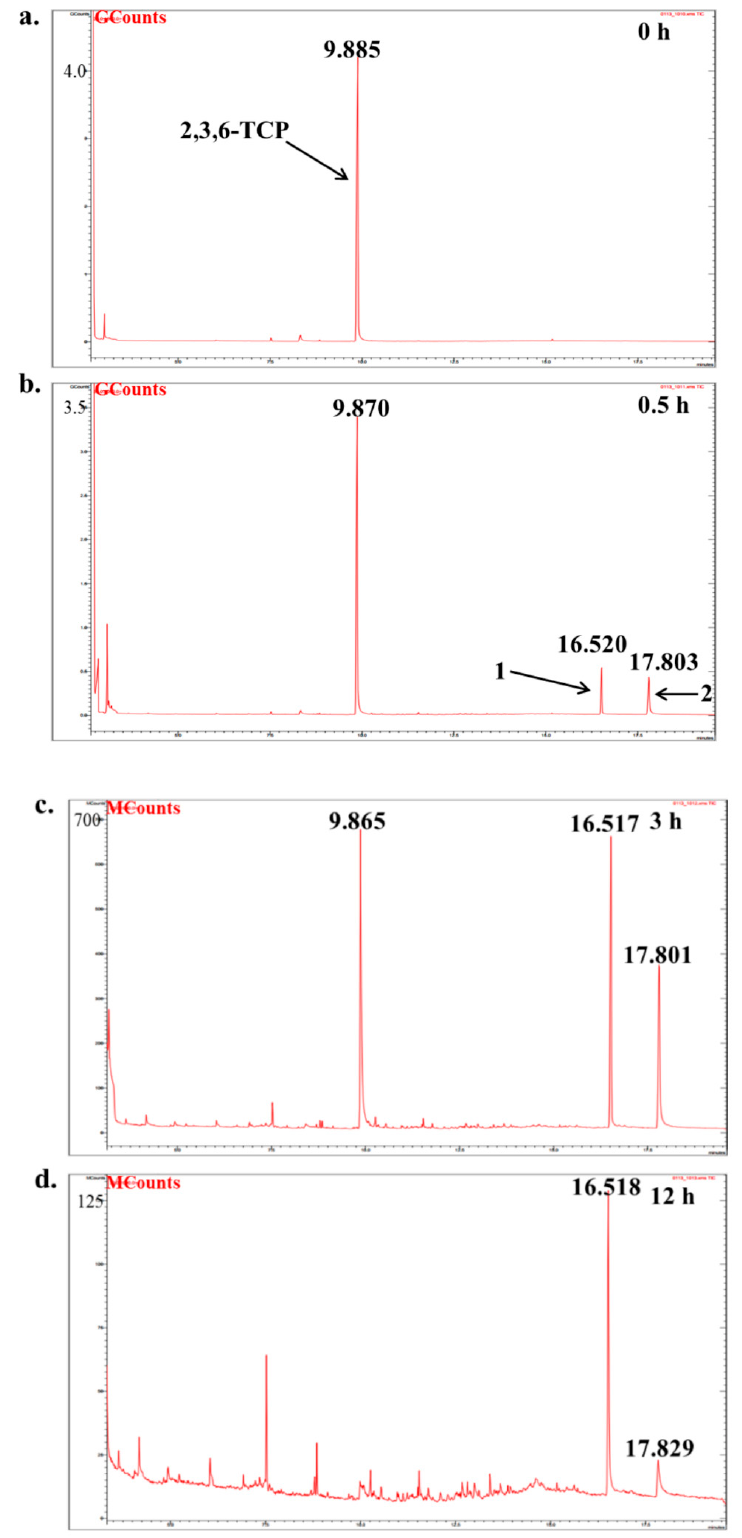
Figure 13. Gas chromatography (GC) peak spectra of degradation products of 2,3,6-TCP degraded by LAC-4 at different time points. ( a ) 0 h, ( b ) 0.5 h, ( c ) 3 h, ( d ) 12